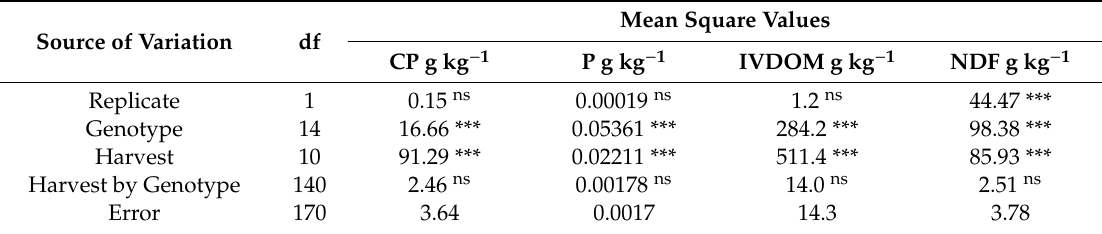
Table 3. Analysis of variance showing sources of variation, degrees of freedom (df), and mean square values for each nutritive value